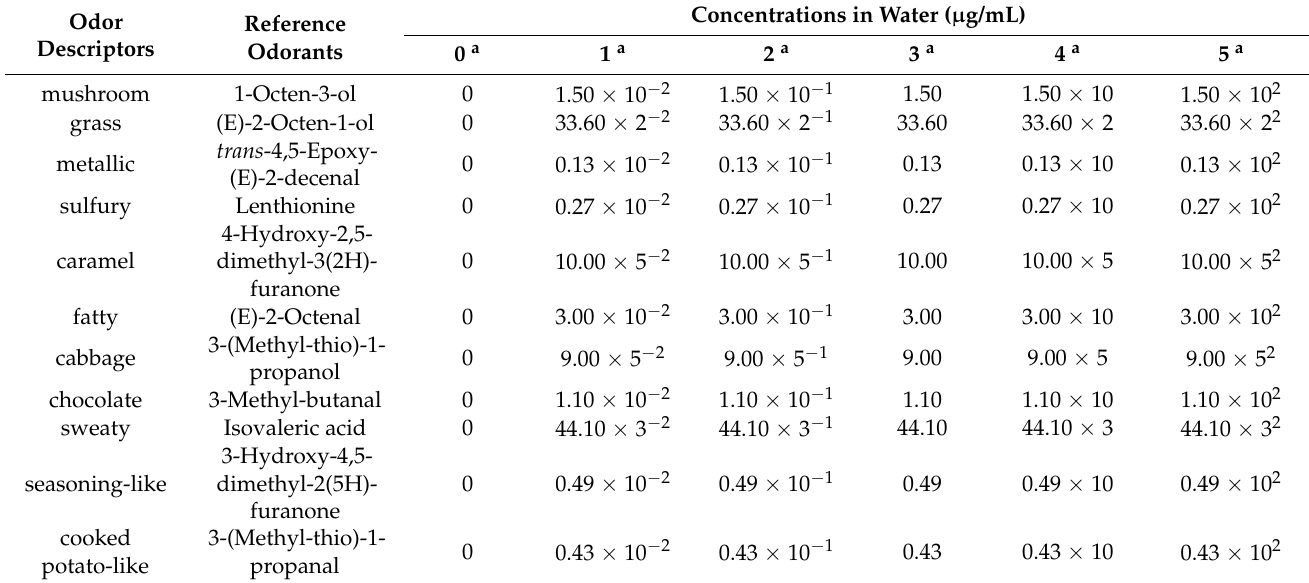
Table 1. The concentrations of the reference odorants in different odor